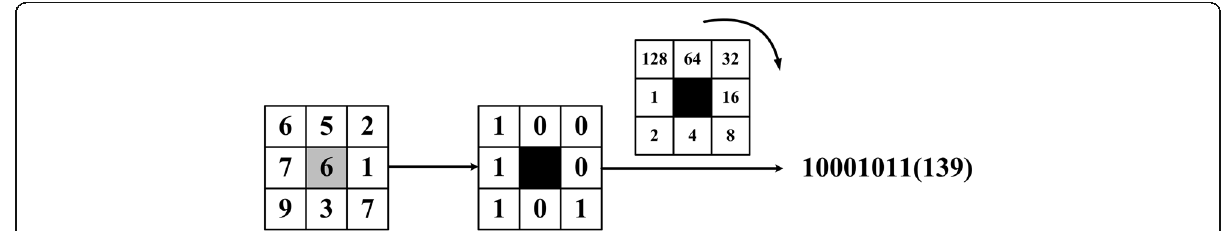
Fig. 1 The LBP coding process in a 3 × 3